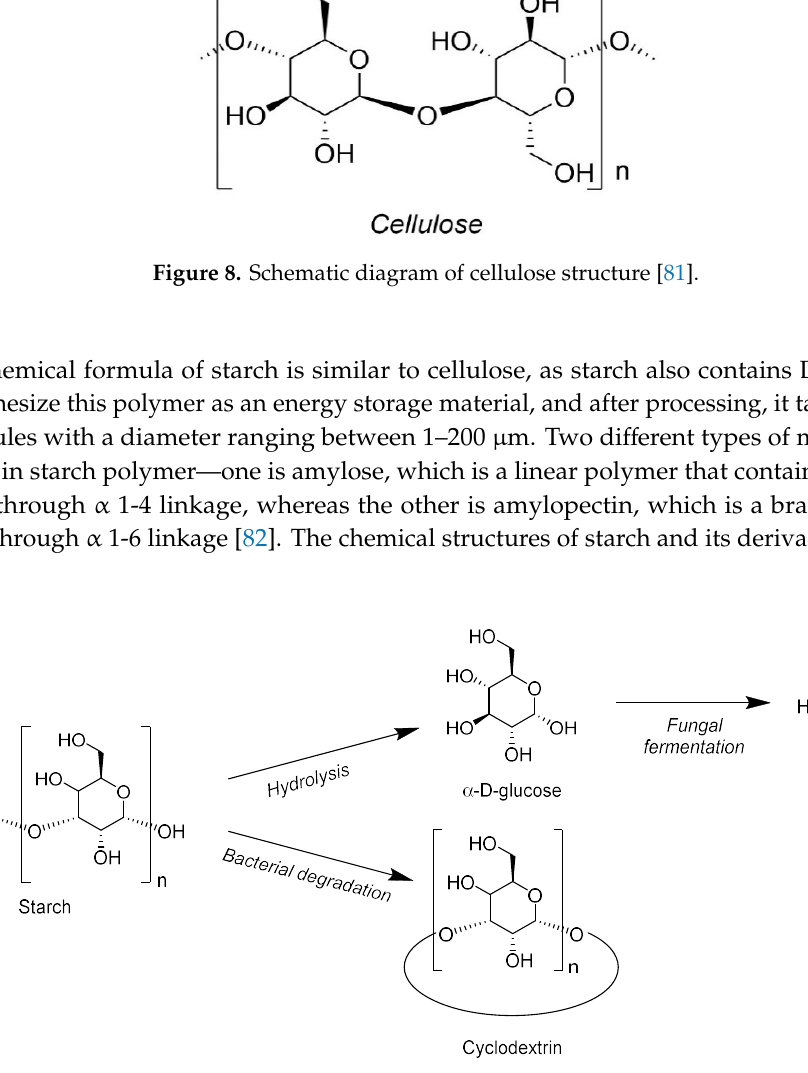
10 of 23 Figure 7. Schematic diagram of cone calorimetry equipment. 7. Potential Bio-Based and Biodegradable Carbonization Agents Recently, researchers have shifted their focus toward the development of flame retardants based on biodegradable resources [76]. Carbon is the major element present in biomass, and according to one study, the entire biomass available on Earth represents approximately 560 billion tonnes of carbon [77]. Therefore, carbon element present in natural compounds can be used as a carbonization agent in intumescent flame retardants [78]. In the following section, biodegradable compounds that have the potential to be used as bio-based carbonization agents in intumescent formulations are briefly discussed. 7.1. Cellulose Cellulose is the most abundant natural source of organic compounds on earth and is the core